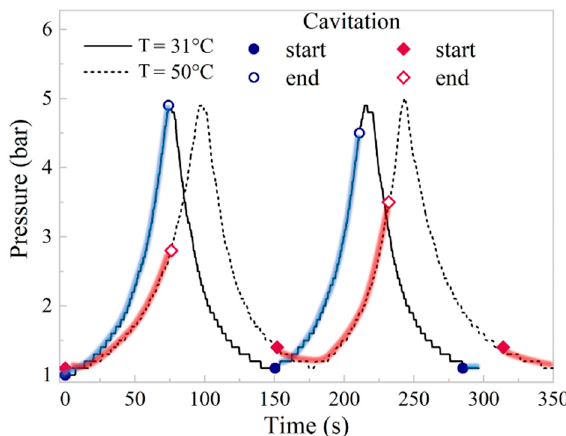
Figure 7. The onset of cavitation at a fixed transducer power of 50% (about 280 W) in Reactor 4 when the external pressure fluctuates over time (loading mode as shown in Figure 4b). The onset and end of cavitation are shown by filled and empty dots, respectively.